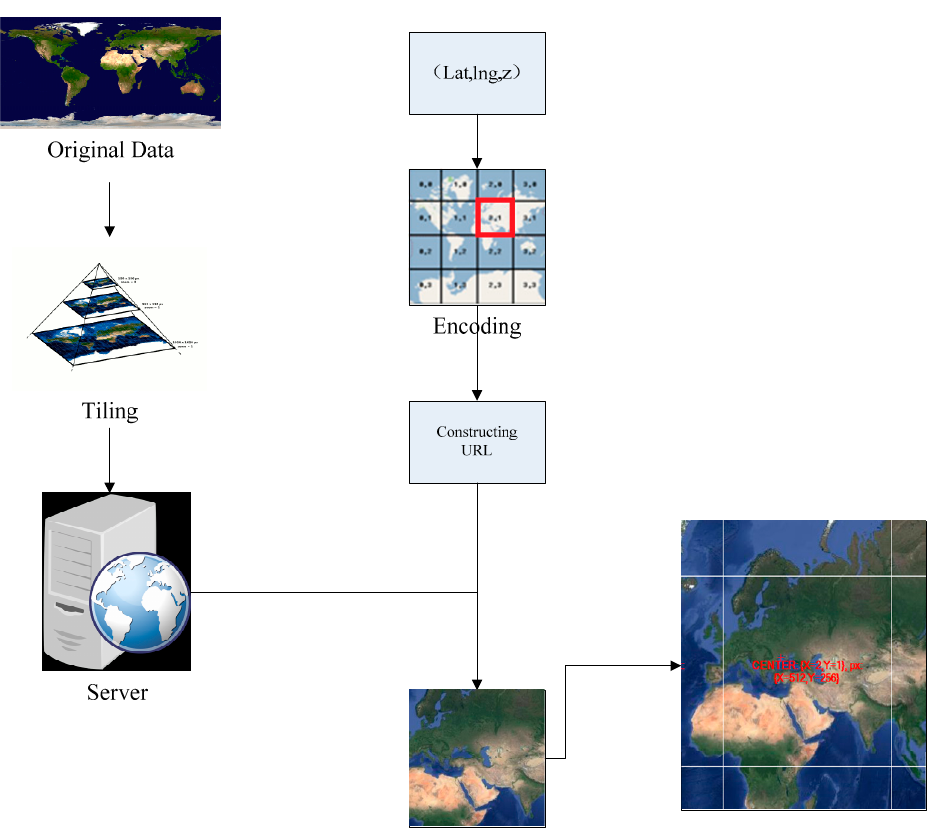
Figure 4. This shows the principle of online map services. Note that some standards do not tile the original data. original data. original data.